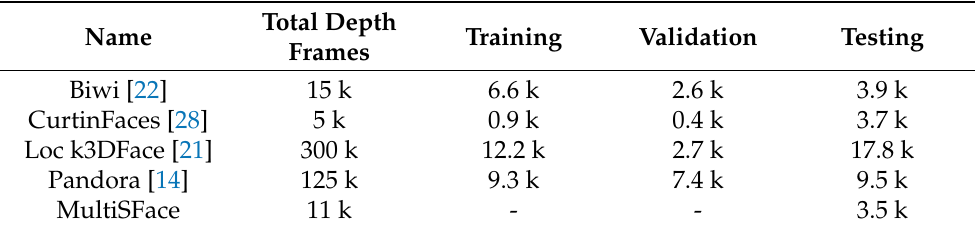
Table 2. Training, validation, and testing splits adopted for each dataset. Frames are split following the procedures described in Section